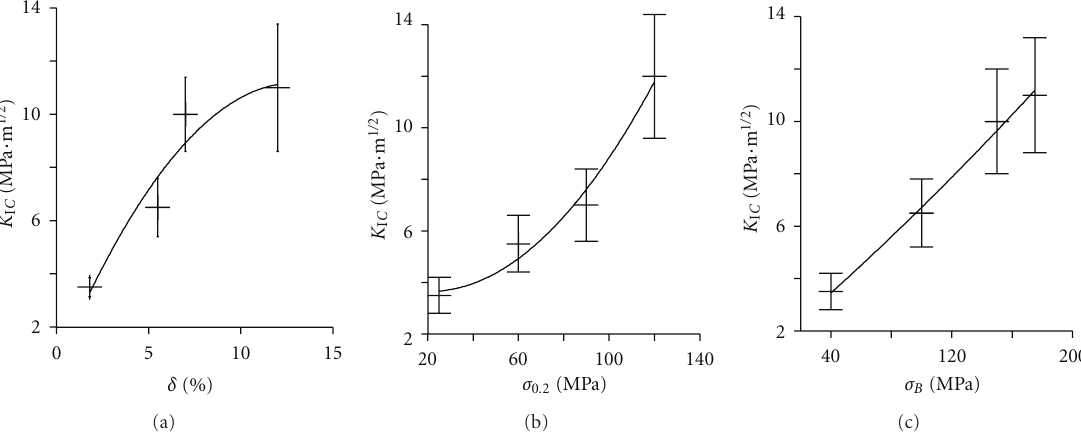
Figure 2: Mechanical properties and fracture toughness correlation of vacuum sintered samples from technical iron PZh4M2